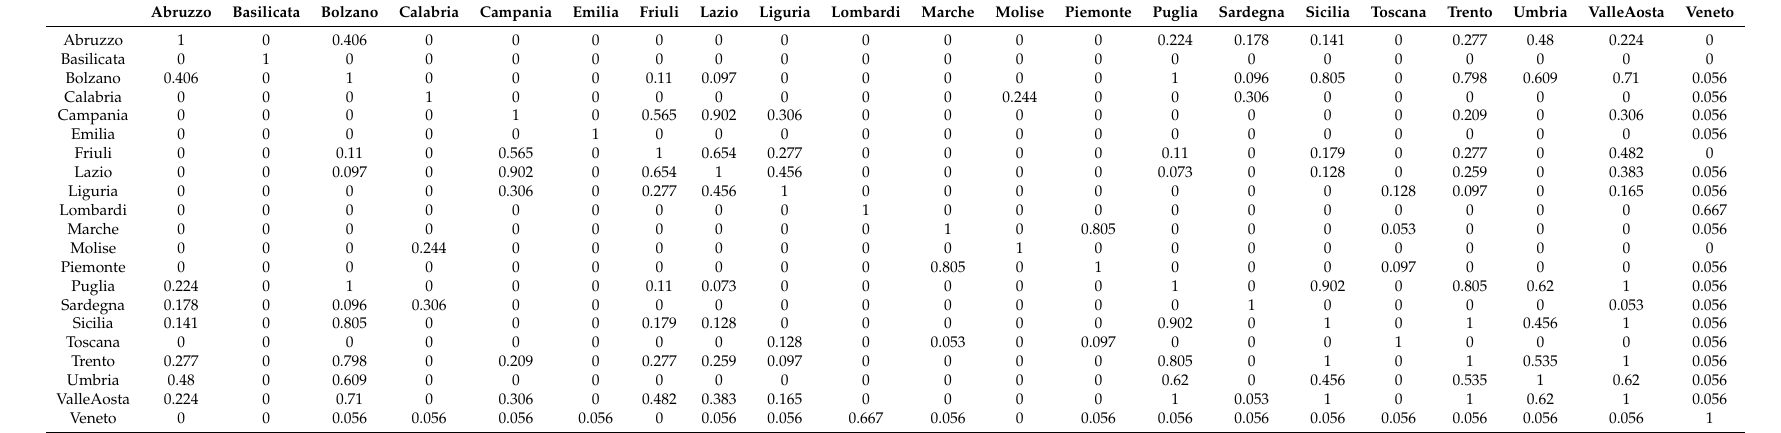
Table A28. Similarity values of Total Currently Positive network in the third